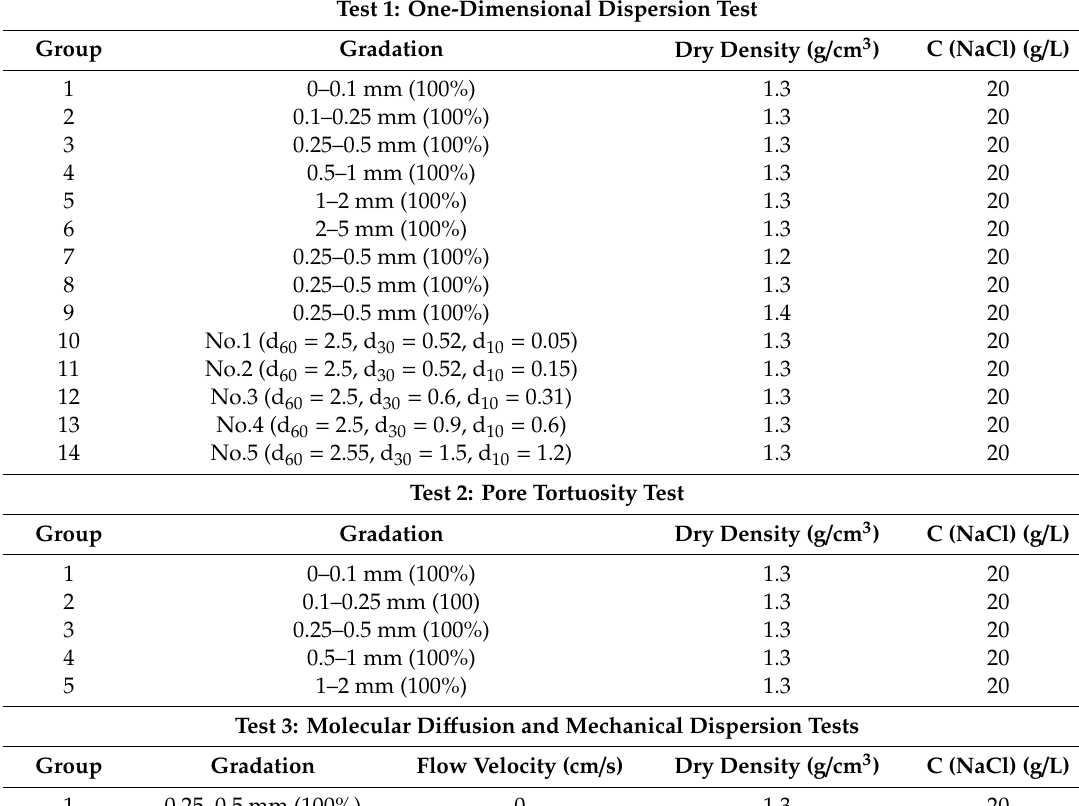
Figure 2. Calcareous sand of various grain sizes. Table 1. Test scheme.